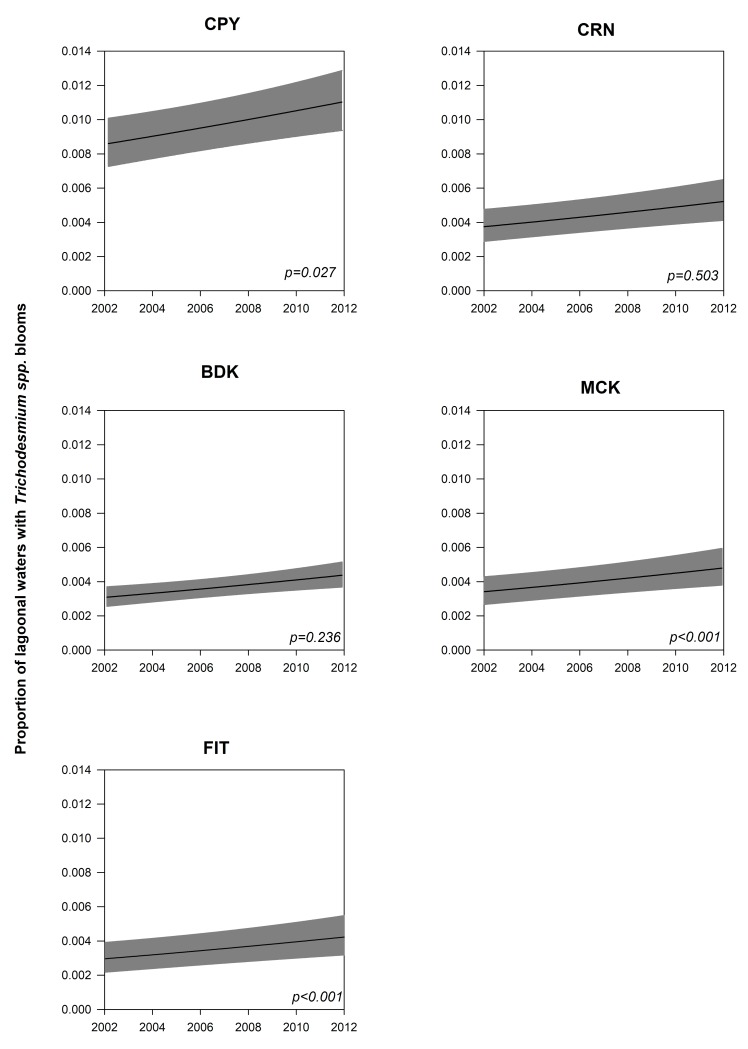
Beta Generalized Additive Model (GAM) outputs modeling the decadal trends in Trichodesmium blooms in each subregion.The y-axis is the proportion of lagoonal waters affected by bloom events in each subregion over the course of the 10-year period. The units are bloom pixels per total (cloud-free) pixels. Confidence intervals for each model are shown as gray bands, and the statistical significance of the trends (p-value) is shown.